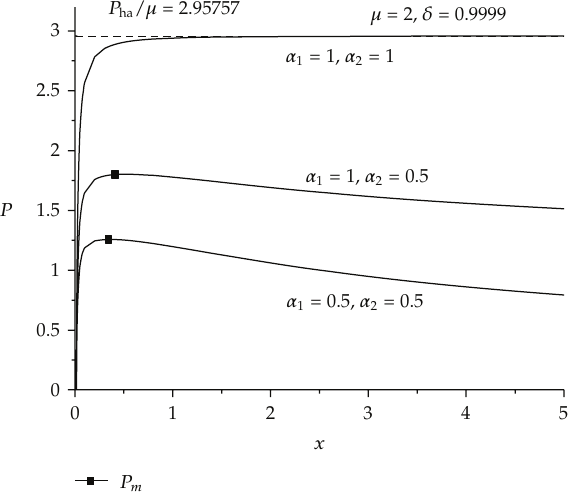
Figure 1: Curves of P ∼ x for 0 < α 1 , α 2 ≤